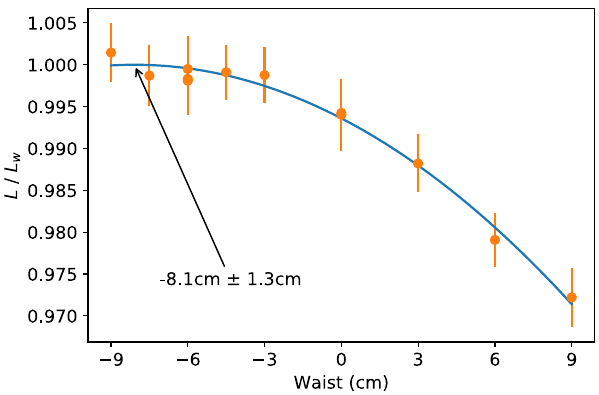
FIG. 14. Luminosity scan of Beam 1 on the vertical